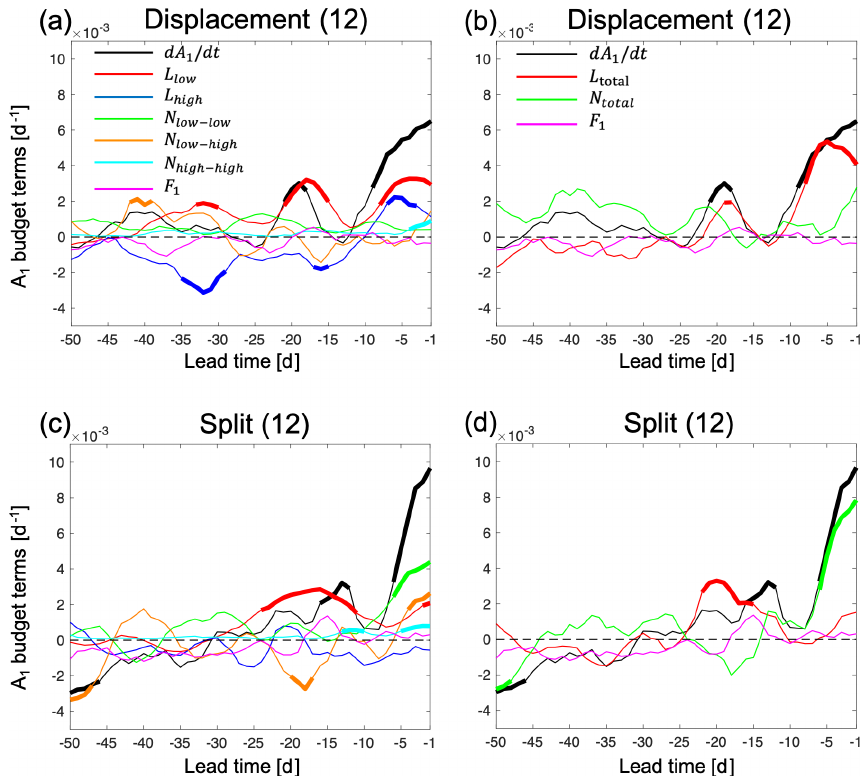
Figure D1. The composite of the A 1 budget as a function of lead time from 50 to 1d before the onset of events in ERA-Interim. (a, b) Com- posite of displacement events; (c, d) composite of split events. Panels (a, c) show each term of the mode equation budget (Eq. 5) separately, and (b, d) show the sum of the linear and nonlinear terms for the two types of events. The number in the bracket in each panel title indicates the number of SSW events. A 5d running mean is applied to all lines. Bold lines indicate the values that are outside the percentile range 2.5 to 97.5 of normal winter day values from bootstrapping as described in the text. The representation of each line color in (c) and (d) is the same as the legend in (a) and (b) ,